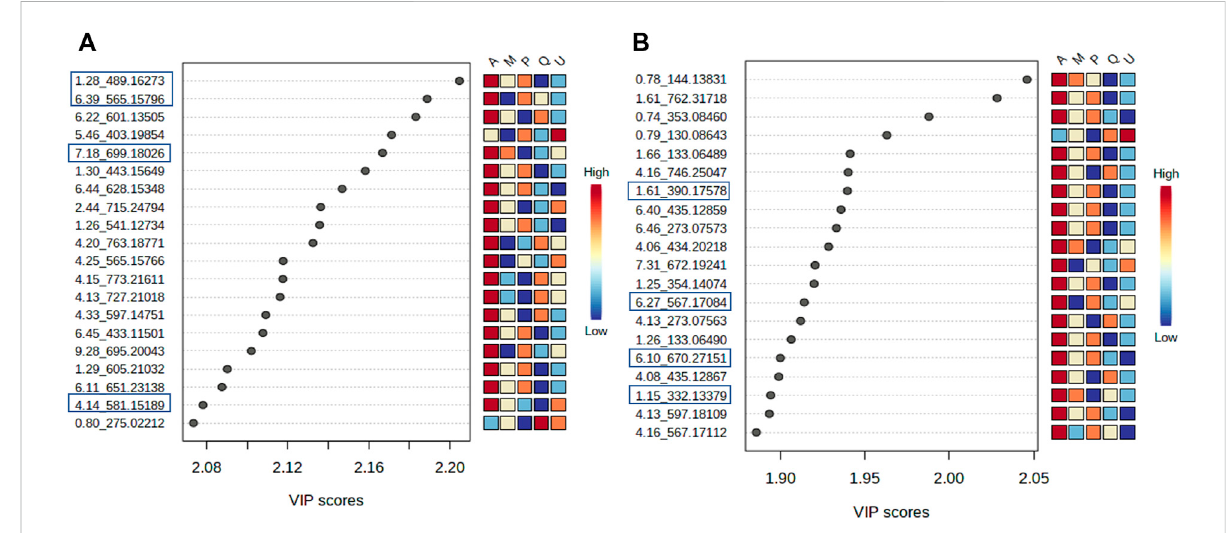
FIGURE 8 Variablesimportantprojection(VIPs)fromPLS-DAof V.album mothertinctures.Discriminationofthesamplesinrelationto V.album hosttrees. (A) VIP of the negative ESI mode and. (B) VIP of the positive ESI mode. Blue rectangles: annotated VIP.